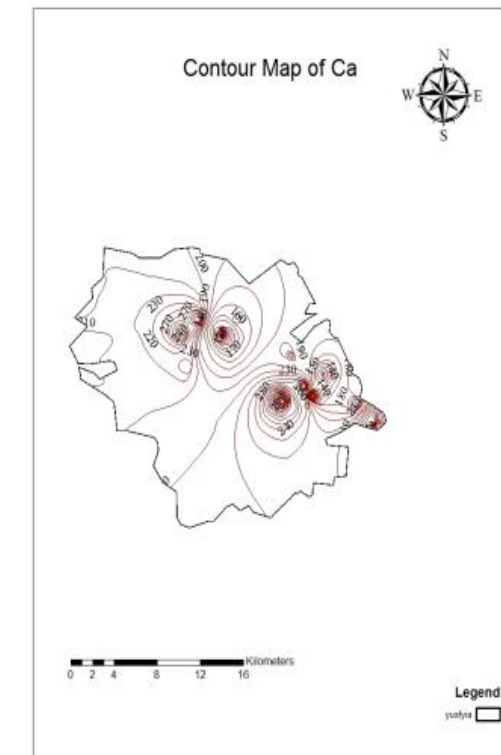
Fig.4: The interpolation and contour line of TDS map in ppm.